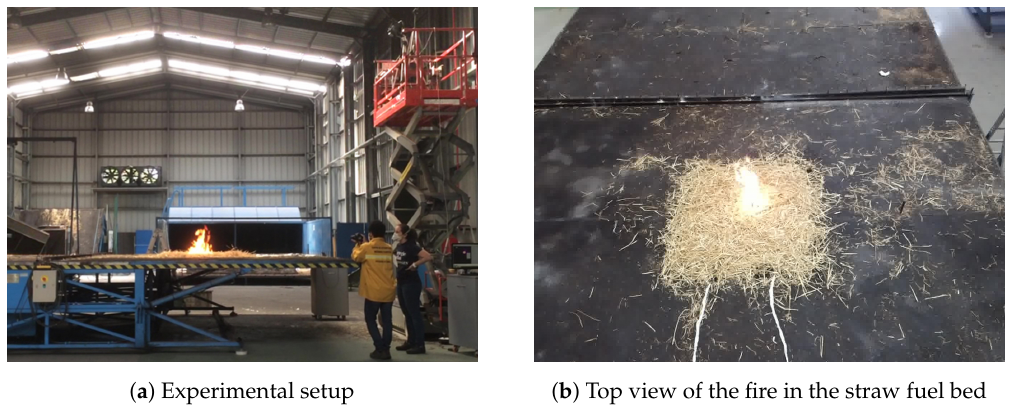
Figure 11. Laboratory trials with the FLIR SC660 mounted on an elevated